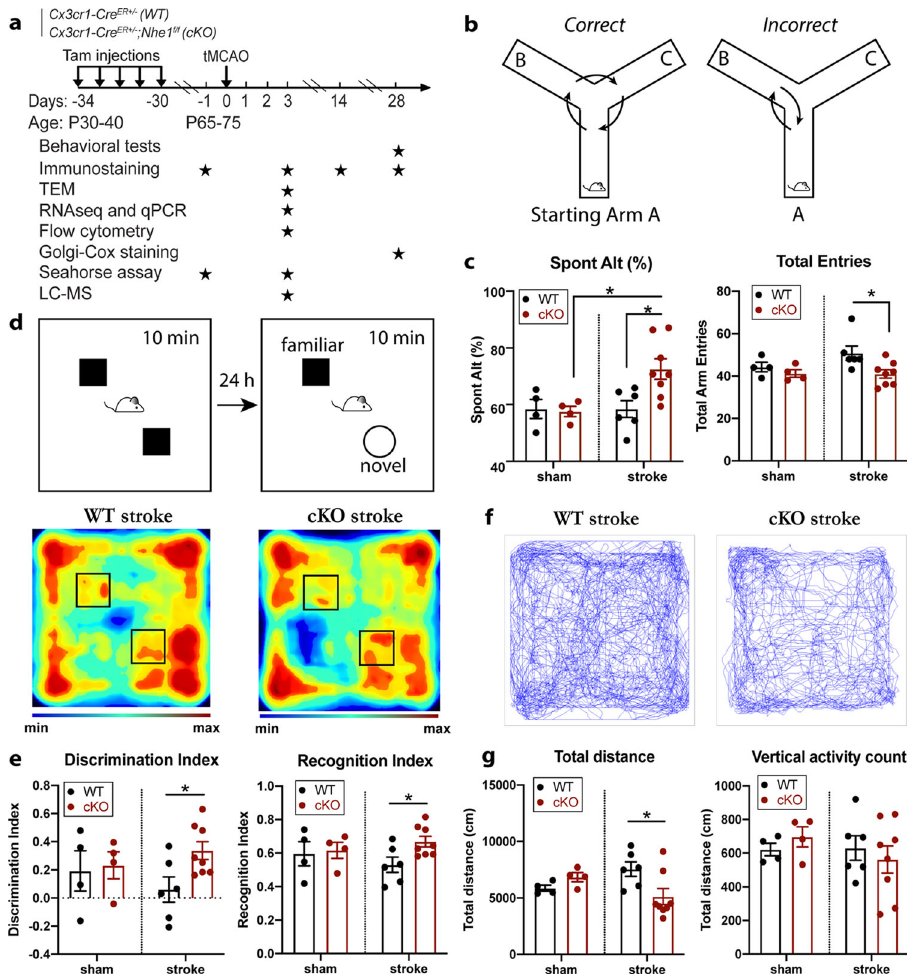
Fig. 1 Microglial Nhe1 cKO mice displayed improved post-stroke cognitive functions. a Experimental timeline. b Illustration of Y-maze spontaneous alternation test. c Percentages of triad spontaneous alternation and total arm entries in WT and cKO mice at 28 d post-sham or stroke. d Illustration of novel object recognition (NOR) test and representative heatmaps of mice exploring the objects. e Calculated discrimination index and recognition index. f Representative paths of WT and cKO mice in the open fi eld (OF) test over a 60-min duration. g Total traveled distance and counts of vertical activity. N = 4 animals for sham groups, and N = 6-8 animals for stroke groups. Data are mean ± SEM. * p <